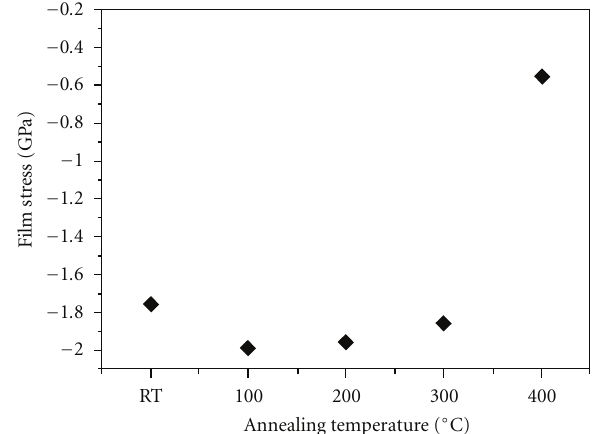
Figure 6: The compressive stress in the AZO film before and after annealing at di ff erent